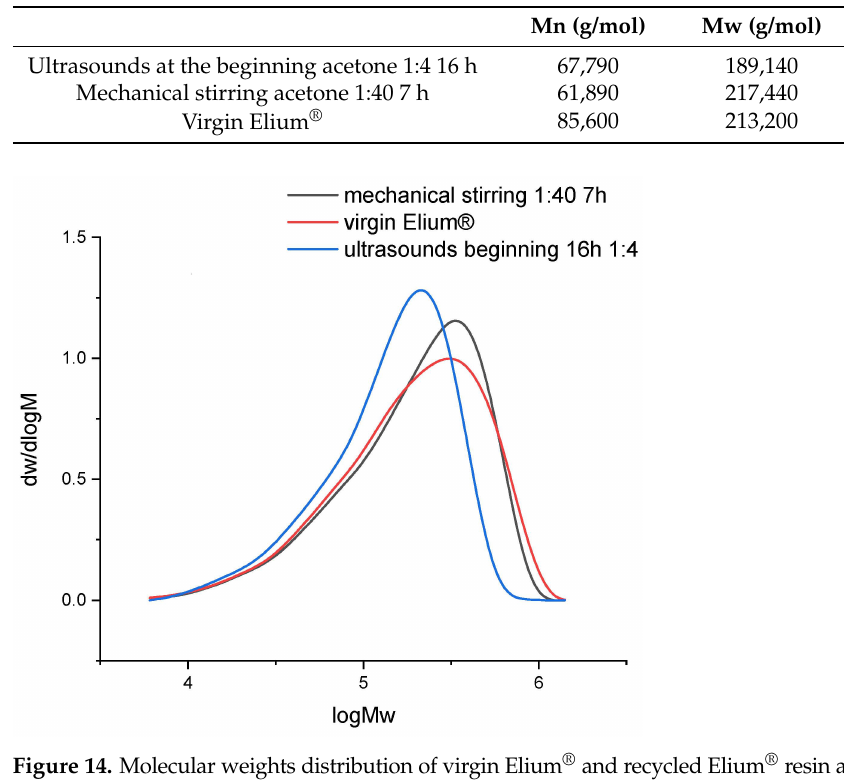
Table 2. Average molecular weights and polydispersity of recycled and virgin resin after dissolution.